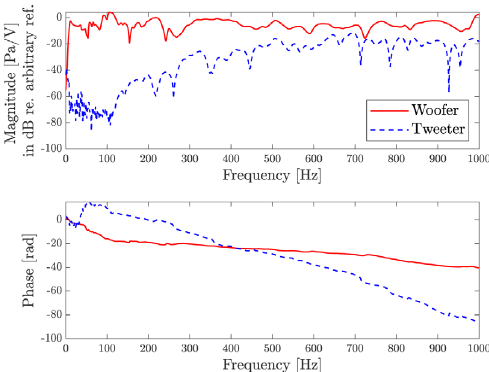
Figure 3. Plant responses between one woofer (solid line) and one tweeter (dashed line) and one of the error microphones at the